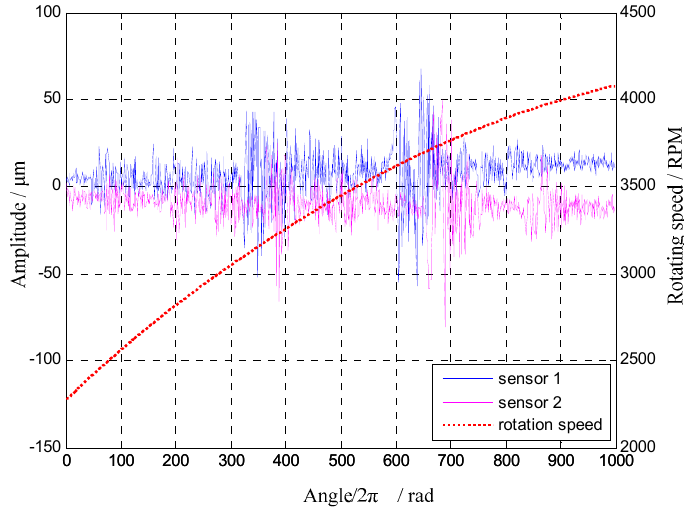
Figure 24. The angularly sampled vibration displacements and the rotating speed of the 11th blade.